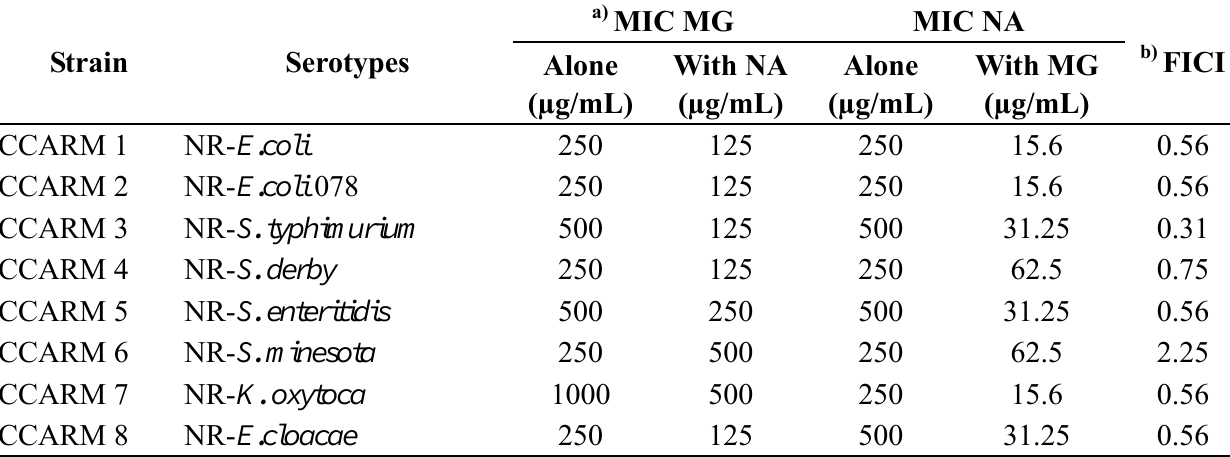
Table 1. Result of the combined effect of methyl gallate (MG) and nalidixic acid (NA) against nalidixic acid-resistant pathogenic bacteria.